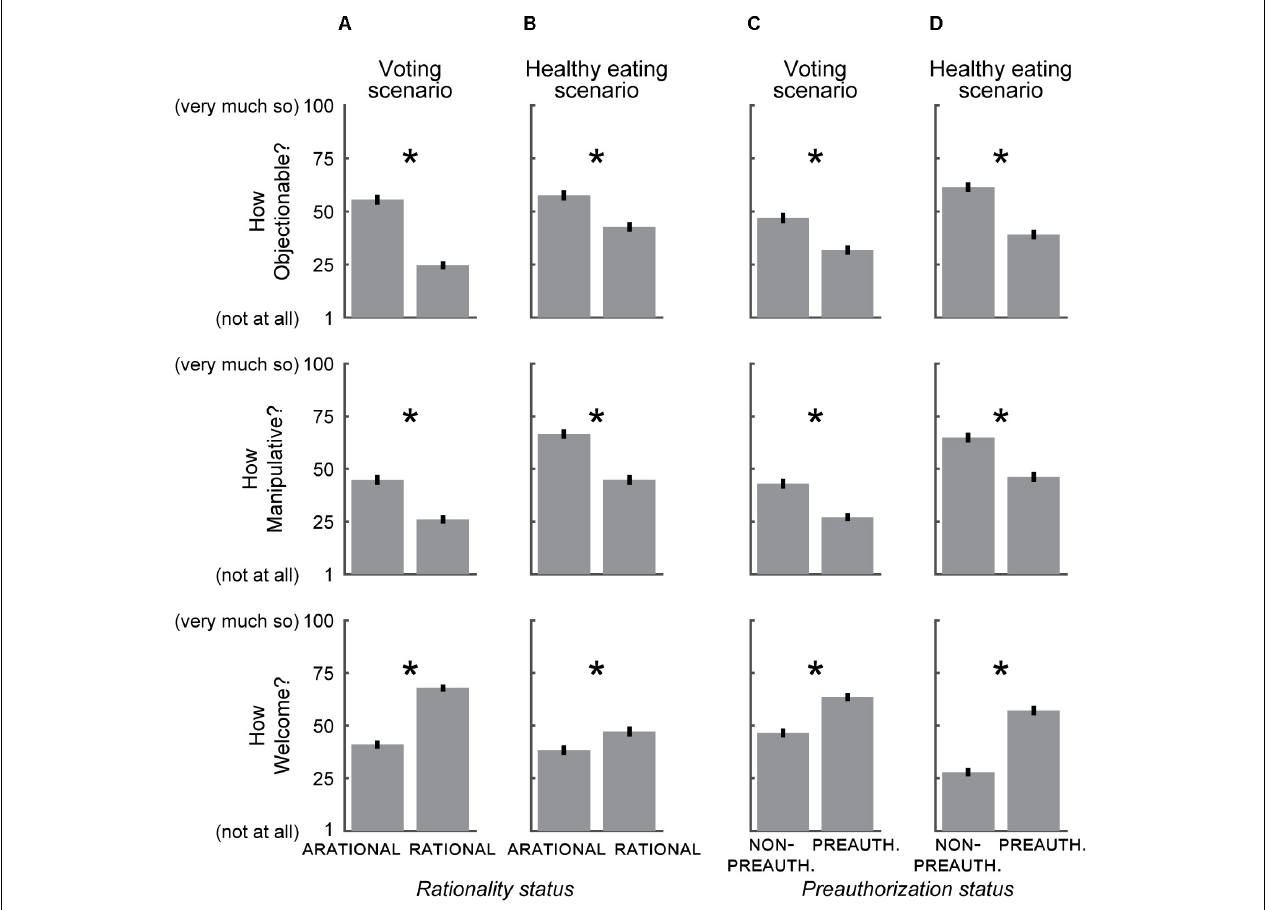
FIGURE 2 | Effect of rationality status and preauthorization status on the extent to which an influence was perceived as undue. (A) In the voting scenario, an ARATIONAL influence was perceived as more Objectionable (upper), more Manipulative (middle) and less Welcome (lower) than a RATIONAL influence. (B) As in (A) , for the healthy eating scenario. (C) In the voting scenario, an influence from a NON - PREAUTHORIZED source was perceived as more Objectionable (upper), more Manipulative (middle), and less Welcome (lower) than an influence from a PREAUTHORIZED source. (D) As in (C) , for the healthy eating scenario. Error bars ± SEM. ∗ p < 0.01, two-tailed unpaired t